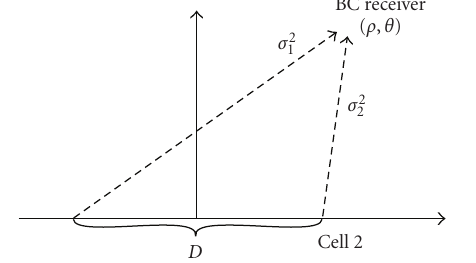
Figure 2: Multicell broadcast coverage.